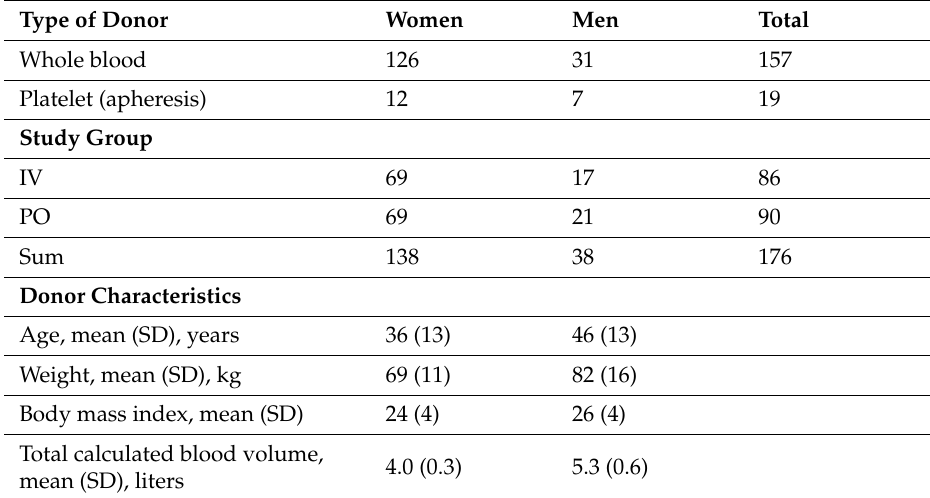
Table 1. Basic characteristics of the study participants (IV, study group with intravenous iron; PO, study group with oral iron; SD standard